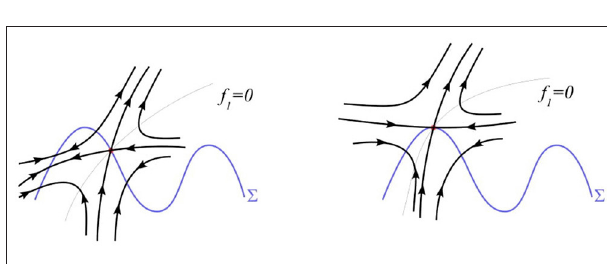
FIGURE 15 | A singular equilibrium-fold bifurcation g = g x = f 1 = 0, g xx 6= 0.